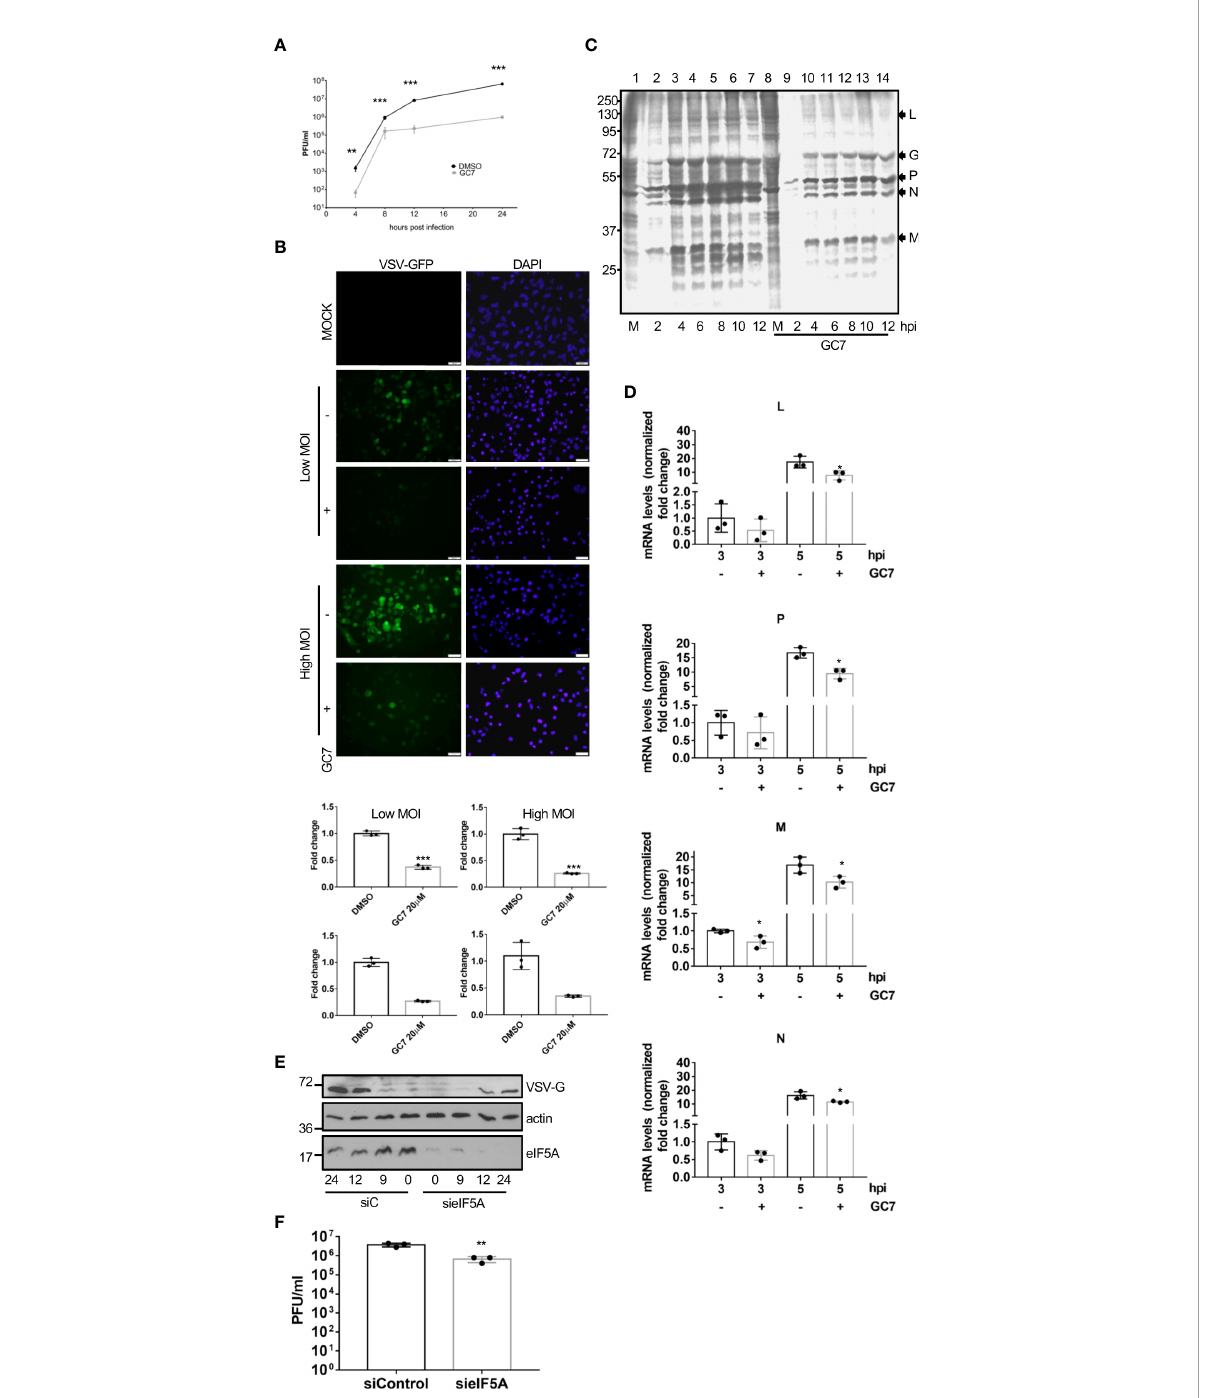
FIGURE 4 Inhibition of eIF5A impaired VSV replication. (A) , Effect of GC7 hypusine inhibition on VSV replication. Data represent the mean and error bars of three biological replicates. Statistical analysis was assessed by a Student ’ s t-test. ***, P<0.0005. (B) , Consequences of hypusine inhibition on VSV-GFP infection. Immuno fl uorescence images showing GFP and DAPI (upper panel). Quanti fi cation, by fl ow cytometry, of the percentage of rVSV-GFP positive cells (lower panel) in cells pretreated with GC7. Data represent the mean and error bars of three biological replicates. Statistical analysis was assessed by a Student ’ s t-test. *, P<0.05. (C) , Metabolic labelling of VSV proteins synthesized in cells treated or not with GC7. (D) , Consequences of hypusine inhibition on viral gene transcription at the indicated times after VSV infection. Data represent the mean and error bars of three biological replicates. Statistical analysis was assessed by a Student ’ s t-test. *, P<0.05. (E) , Effect of eIF5A1 downmodulation on viral glycoprotein G expression. (F) , Effect of eIF5A1 downmodulation on VSV replication. Data represent the mean and error bars of three biological replicates. Statistical analysis was assessed by a Student ’ s t-test. **,